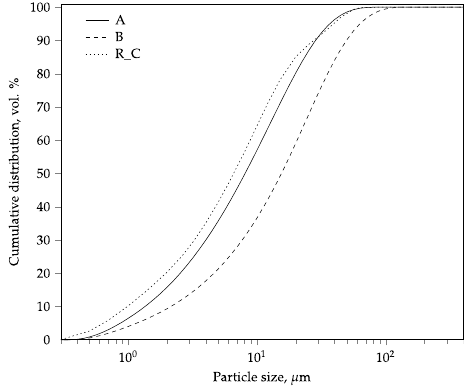
Figure 2. Particle size (cumulative) distribution for R_C, A and